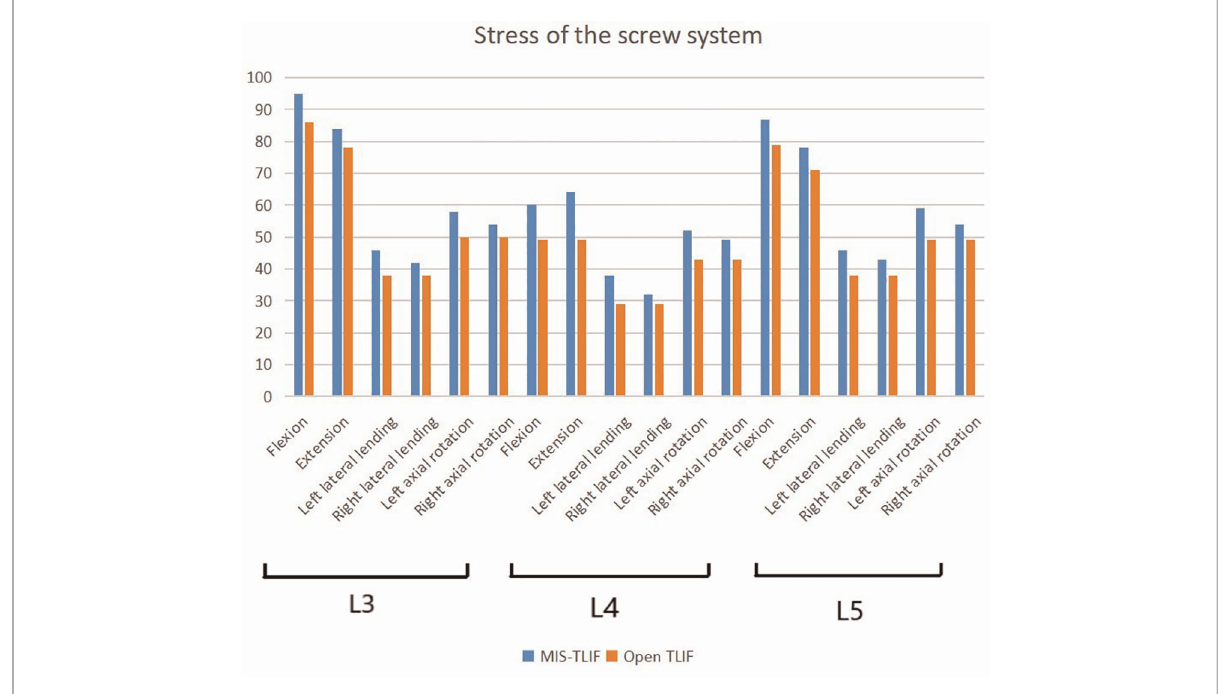
FIGURE 7 The stress value of screw systems in two kinds of 2-level model under different conditions.